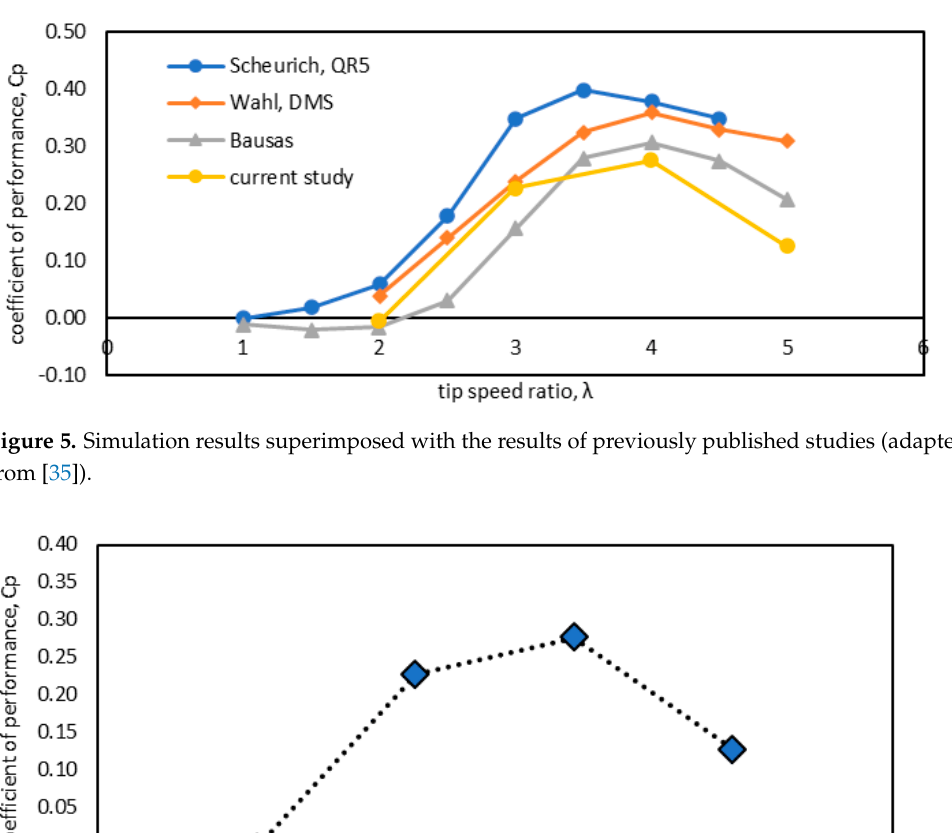
Figure 4. Time step size (TSS) study results on moment coefficient values for ( a ) λ = 3, ( b ) λ = 4 and ( c ) λ = 5.